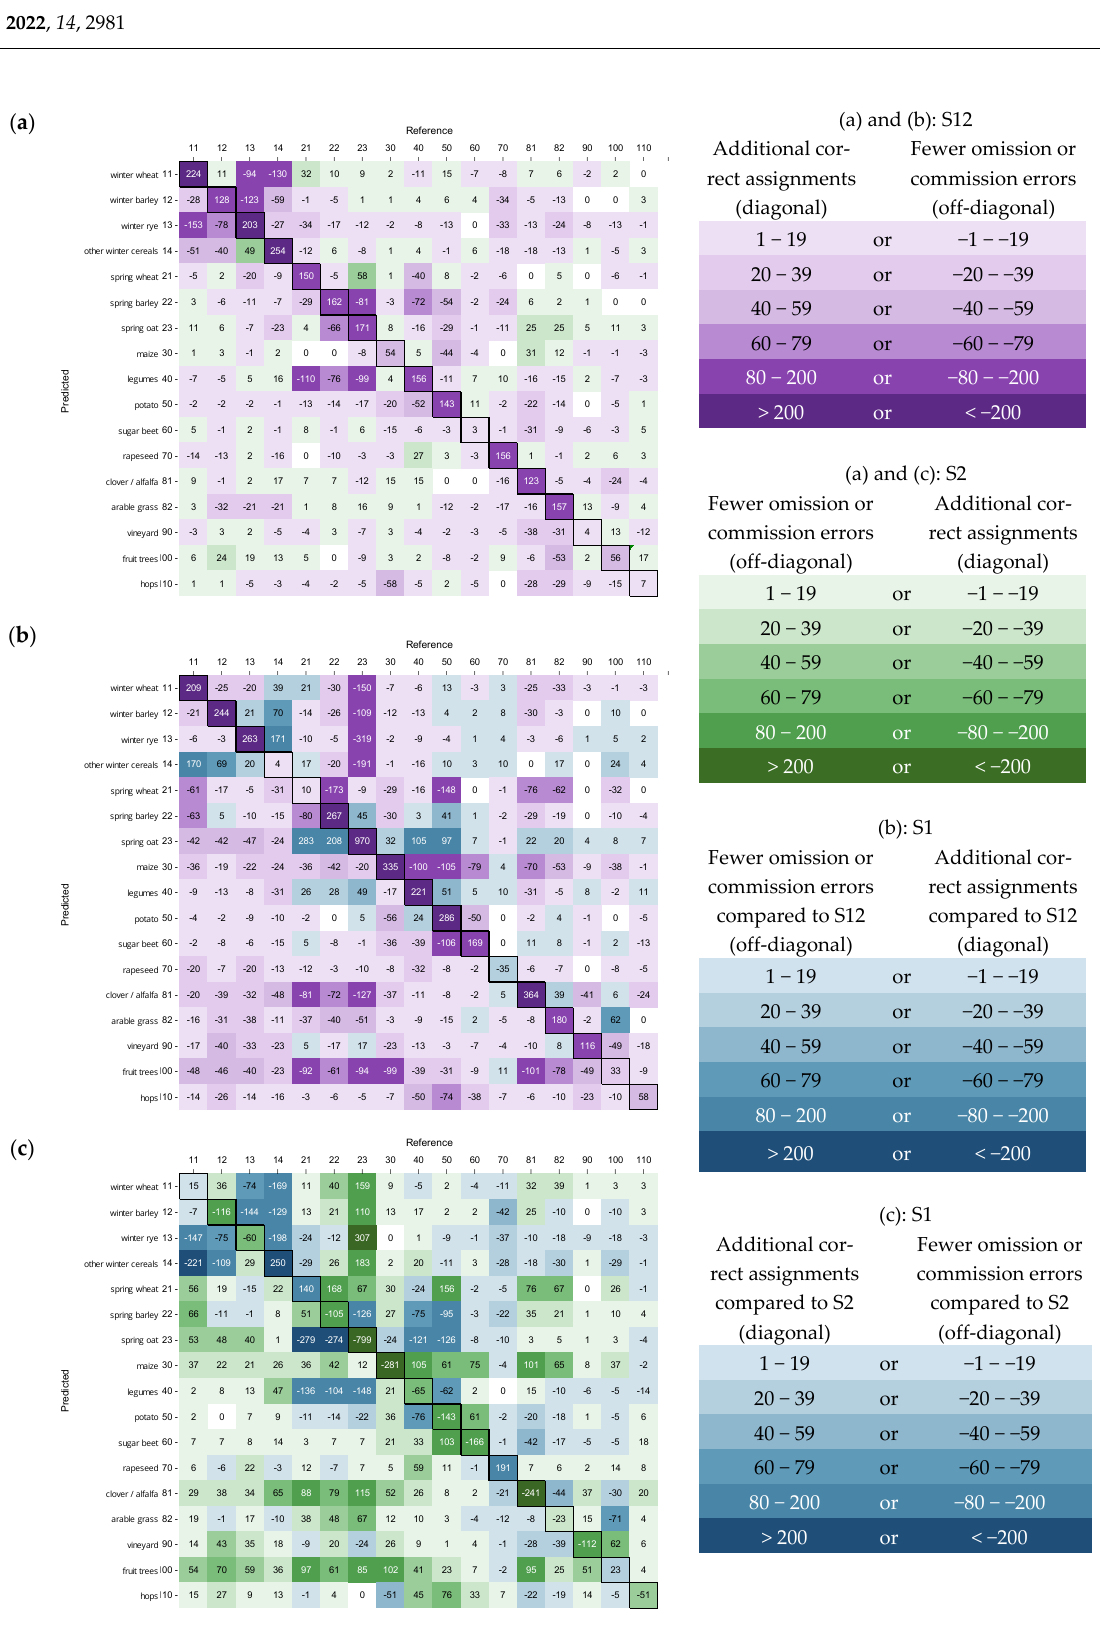
Figure 6. Sample count Confusion Matrices (CM) generated by subtracting ( a ) the S2 CM from the S12 CM, ( b ) the S1 CM from the S12 CM, and ( c ) the S2 CM from the S1 CM. The colors indicate if the S12 (violet) approach achieved more correct class assignments (diagonal)/less omission and commission errors (off-diagonal), or if S2 (green), or S1 (blue) features only achieved better